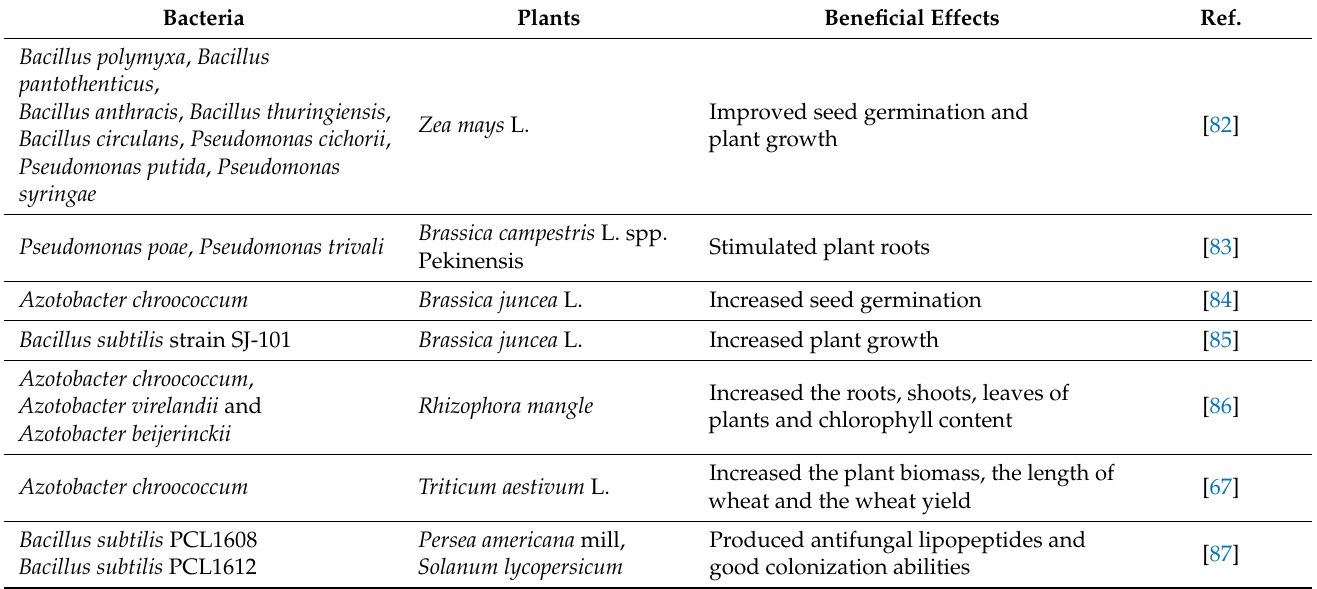
Table 1. Effects of Azotobacter , Bacillus and Pseudomona s species on plant growth and